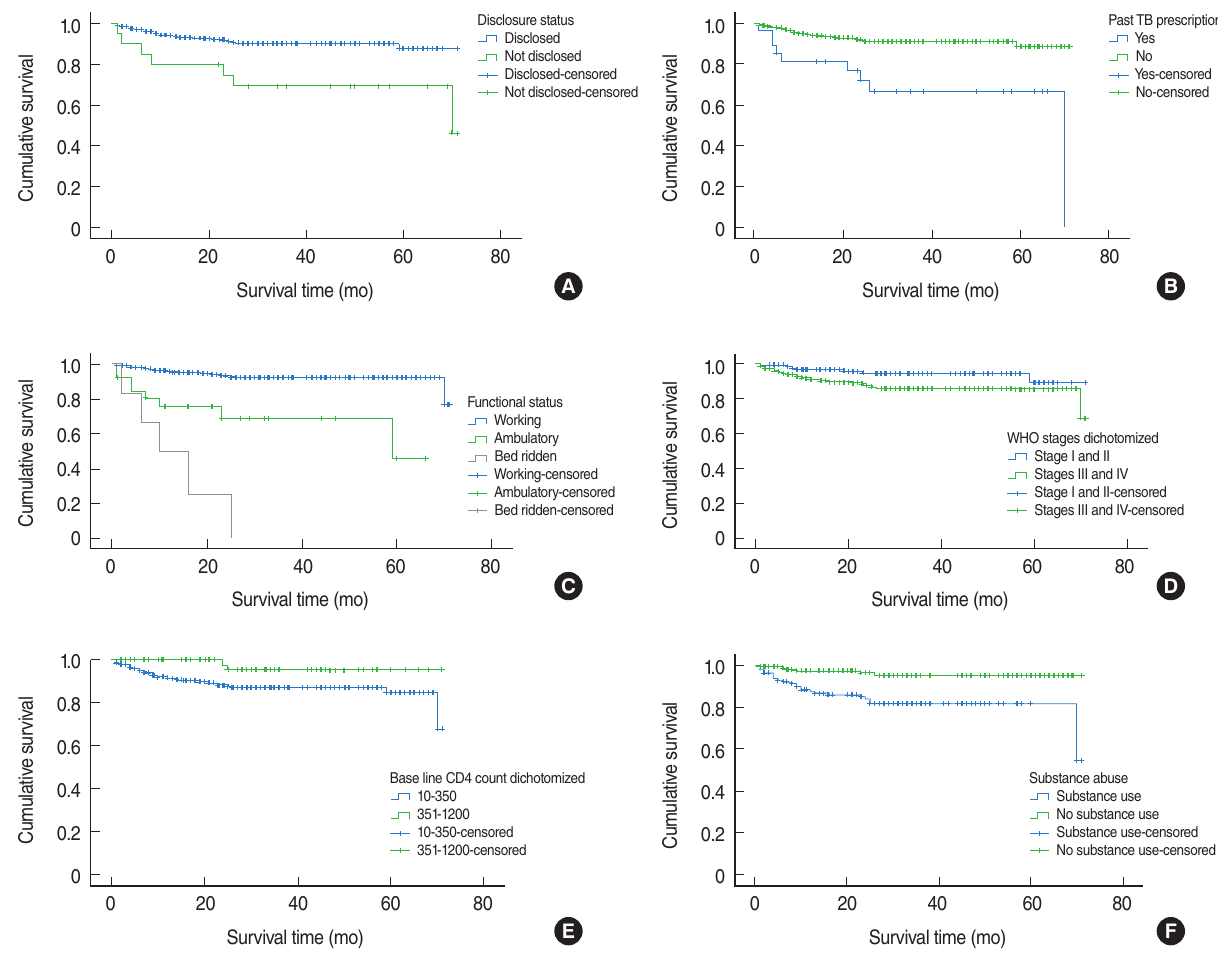
Figure 2. Survival outcomes (Kaplan-Meier analysis) by disclosure status (A), past tuberculosis (TB) treatment (B), functional status (C), WHO staging (D), baseline CD4 cell count (E), and substance abuse (F) among HIV patients receiving antiretroviral therapy at Jinka Hospital, South Omo, Ethiopia, 2016 (n=350). WHO, World Health Organization; HIV, human immunodeficiency